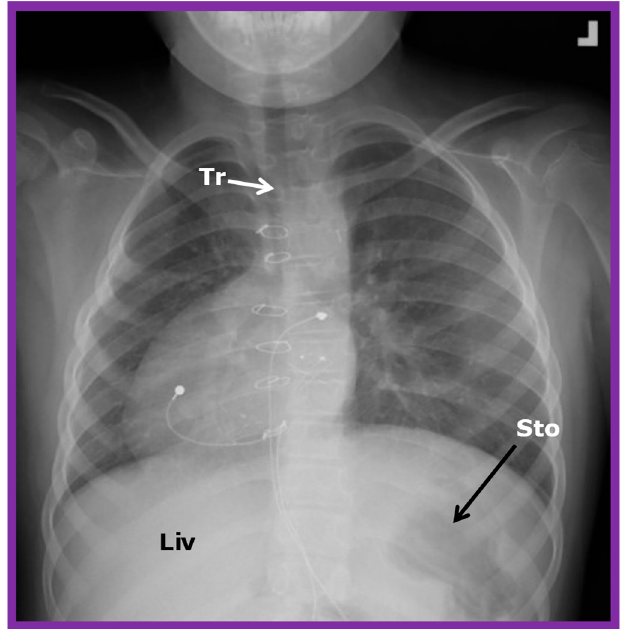
Figure 3. Chest X-ray of a child demonstrating the heart in the right chest (dextrocardia). The positions of the liver (Liv) on the right side, and stomach (Sto) on the left side are seen, indicative of visceral situs solitus. This is described as isolated dextrocardia. Tr. Trachea; inverted L, indicates left. Sternal and pacemaker wires (not labeled) are seen and are related to prior surgery. Modified from reference [5].